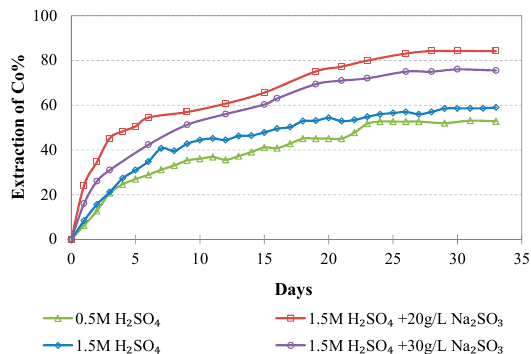
Figure 5. Evolution of % Ni extraction vs time during LAI leaching for different tests.